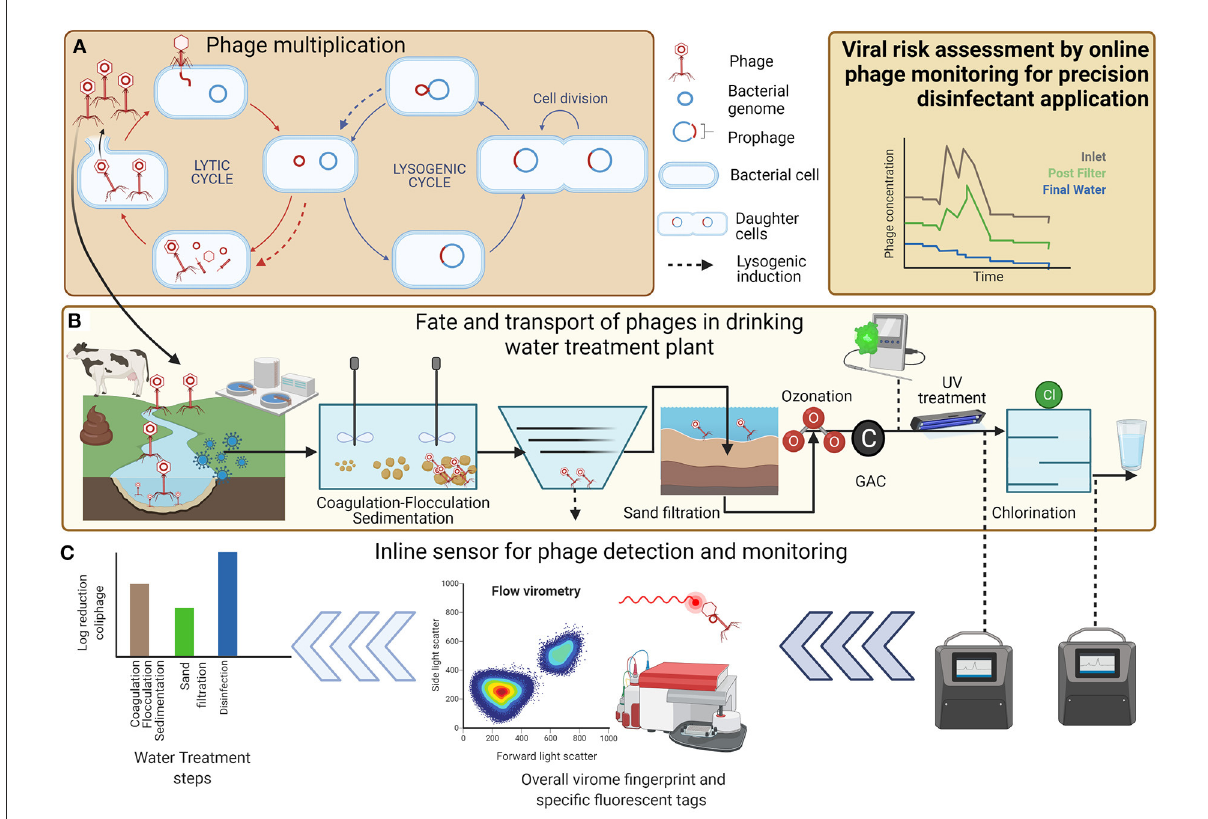
FIGURE1 Schematic representing coliphages as viral indicators of sanitary significance for drinking water. Each panel represents a different example of this field. (A) Phage multiplication in environmental water matrices, (B) fate and transport of phages in drinking water treatment plant, and (C) inline sensors for phage detection and monitoring for disinfection optimization and risk